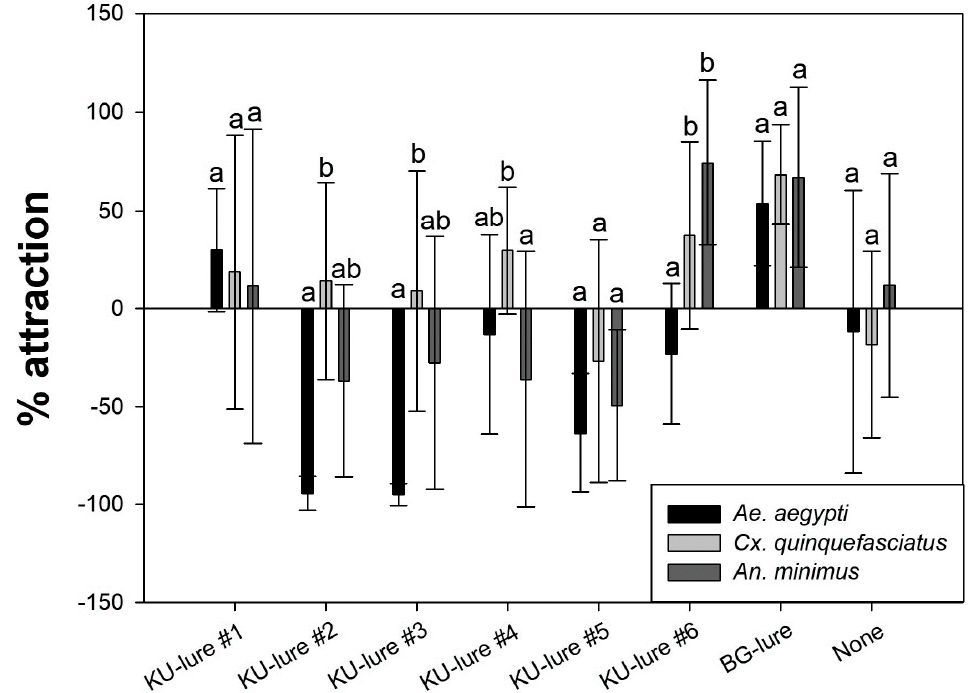
Figure 4. Percent attraction between susceptible strains of Aedes aegypti , Culex quinquefasciatus , and Anopheles minimus . Each KU-lure candidate tested with 0.01 g while BG-lure was 0.05 g. Different letters on bar indicate statistical significance with 95% confidence using Kruskal–Wallis H test for multiple comparisons ( p < 0.05).